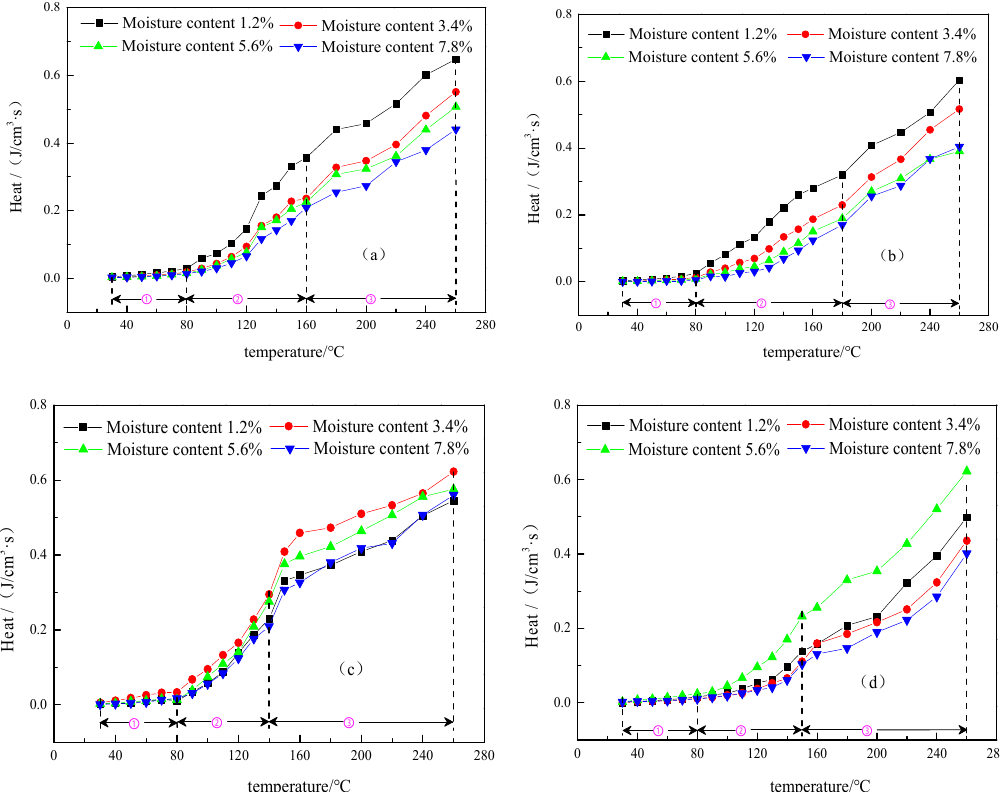
Figure 7. The curves of maximum exothermic strength for anthracite ( a ), fat coal ( b ), long flame coal ( c ) and lignite ( d ) at four different low moisture contents. ① indicates the slow oxidation stage, ② indicates the rapid oxidation stage, and ③ indicates the violent oxidation stage.